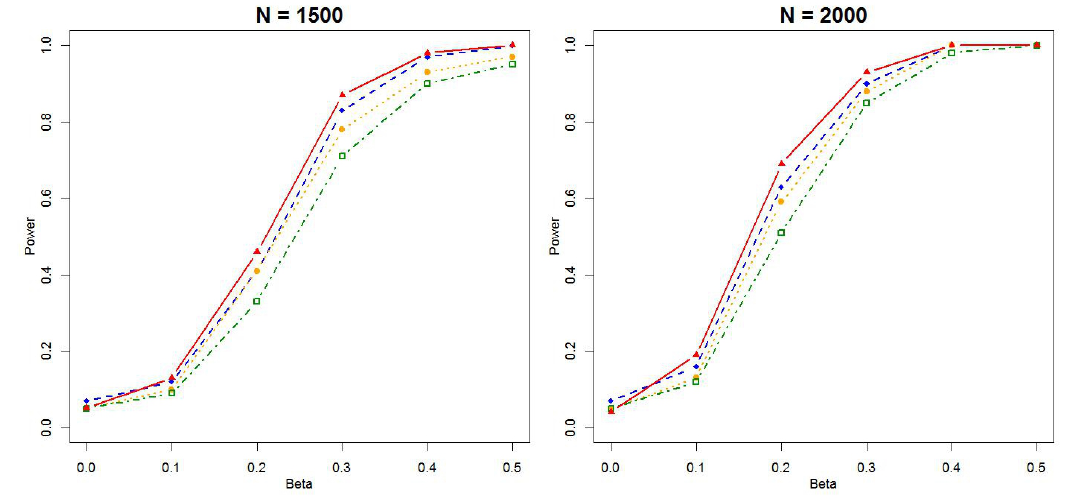
Figure 6. Power simulation for ZINB outcomes based on random LD blocks, single causal locus, effect in NB distribution.